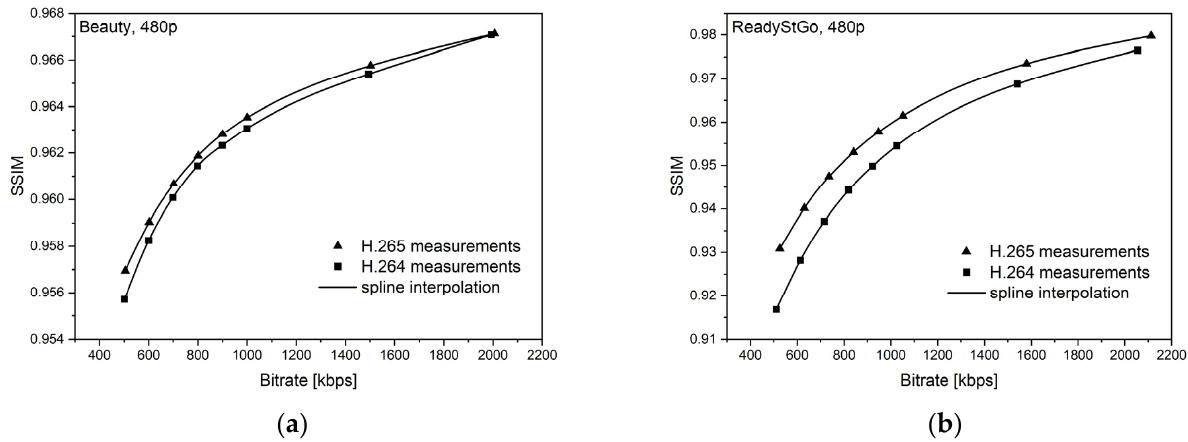
Figure 9. Comparison of the H.264 and H.265 codecs, based on the SSIM metric, for two different videos: ( a ) slow motion video; ( b ) fast motion video.